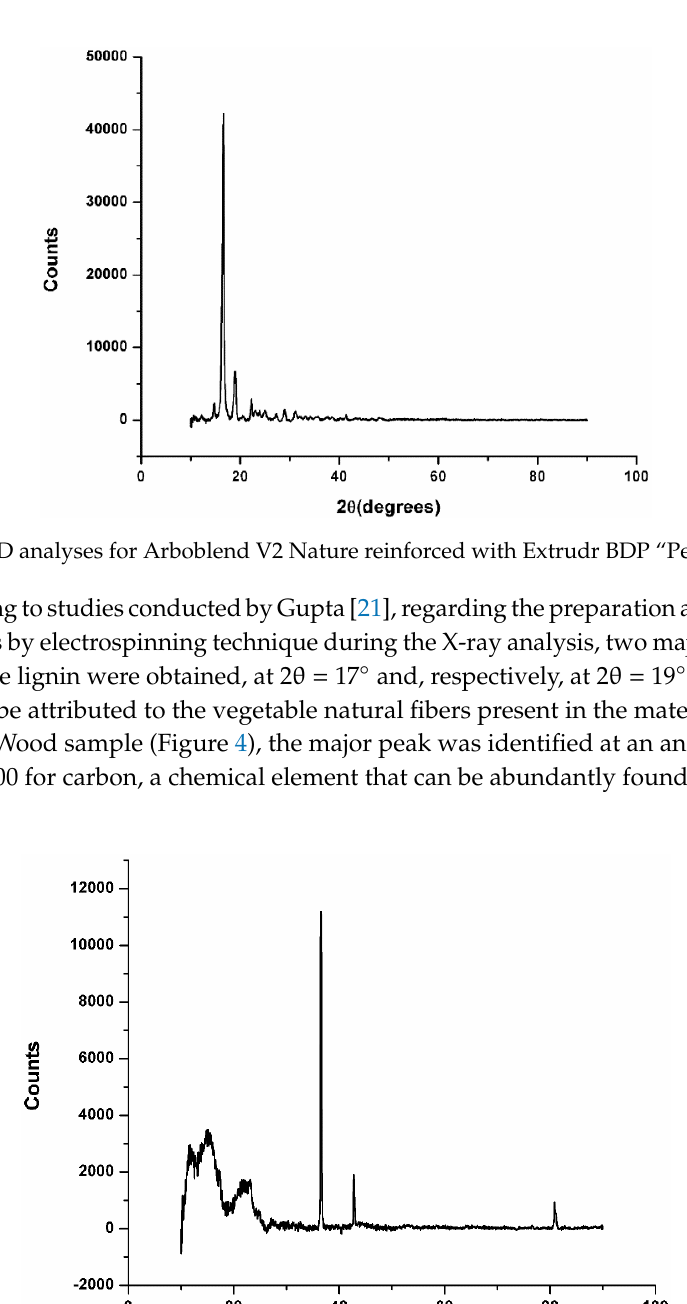
( d ) Figure 2. The EDAX (Energy Dispersive X-ray Analysis) wire images: ( a ) Arboblend V2 Nature, ( b ) Arbofill Fichte, ( c ) Arboblend V2 Nature reinforced with Extrudr BDP “Pearl”, ( d ) Fiber Wood. According to the obtained results from this analysis that identifies the material chemical elements, we distinguished as dominant constituents the carbon and the oxygen (in atomic and mass percentage) elements which, in the case of three of the biodegradable materials studied, Arboblend V2 Nature, Arboblend V2 Nature reinforced with Extrudr BDP “ Pearl ”, and Fiber Wood, were found in approximately equal proportions. Their presence in such a large quantity confirms their high biodegradation rate because they contain chemical elements that are abundantly found in the chemical structure of plants, under different types of oxygen-carbon bonds (specific to cellulose, hemicellulose, lignin, lignin derivatives, etc.). Arbofill Fichte material revealed a mass and atomic ratio of approximately 82% carbon and 18% oxygen, which was most likely due to the presence of natural vegetable fibers in its structure. 3.3. The XRD Analysis The X-ray diffraction analysis is the most commonly used technique to characterize the